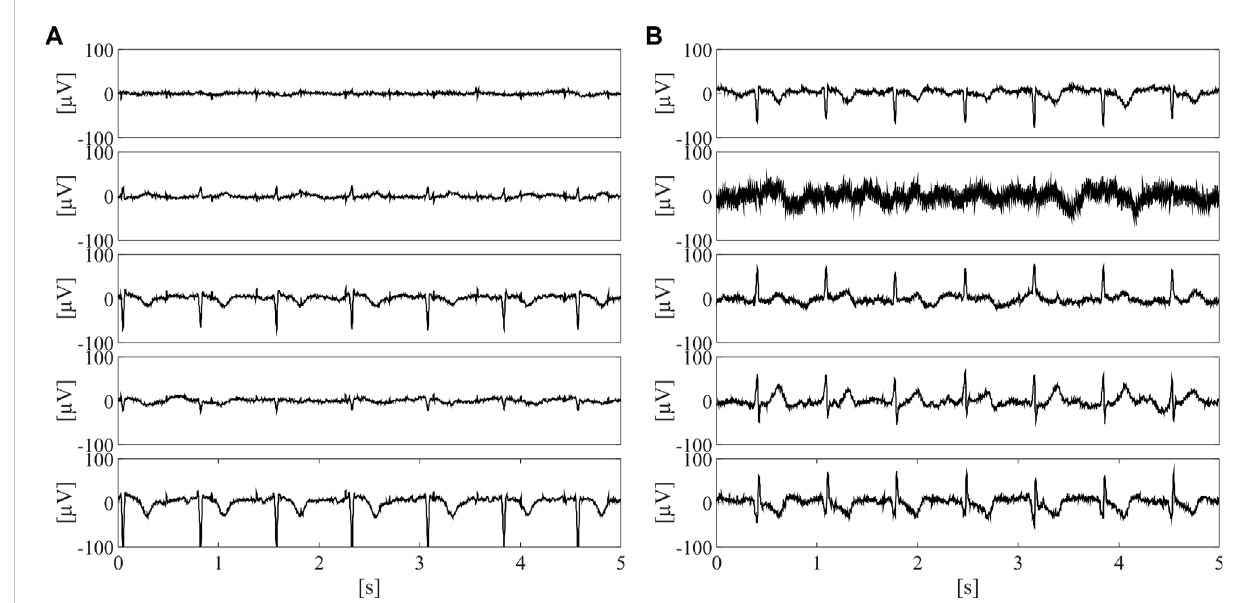
FIGURE 6 Five 5-s long abdominal segments from the subjects showing the highest [i.e., the 38th, (A) ] and the lowest number of informative signals [i.e., the 2 nd , (B) ] after